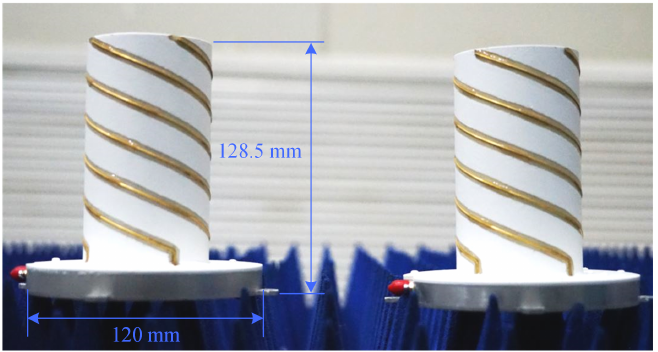
Figure 2. Quadrifilar helix antenna equipped in LT-1